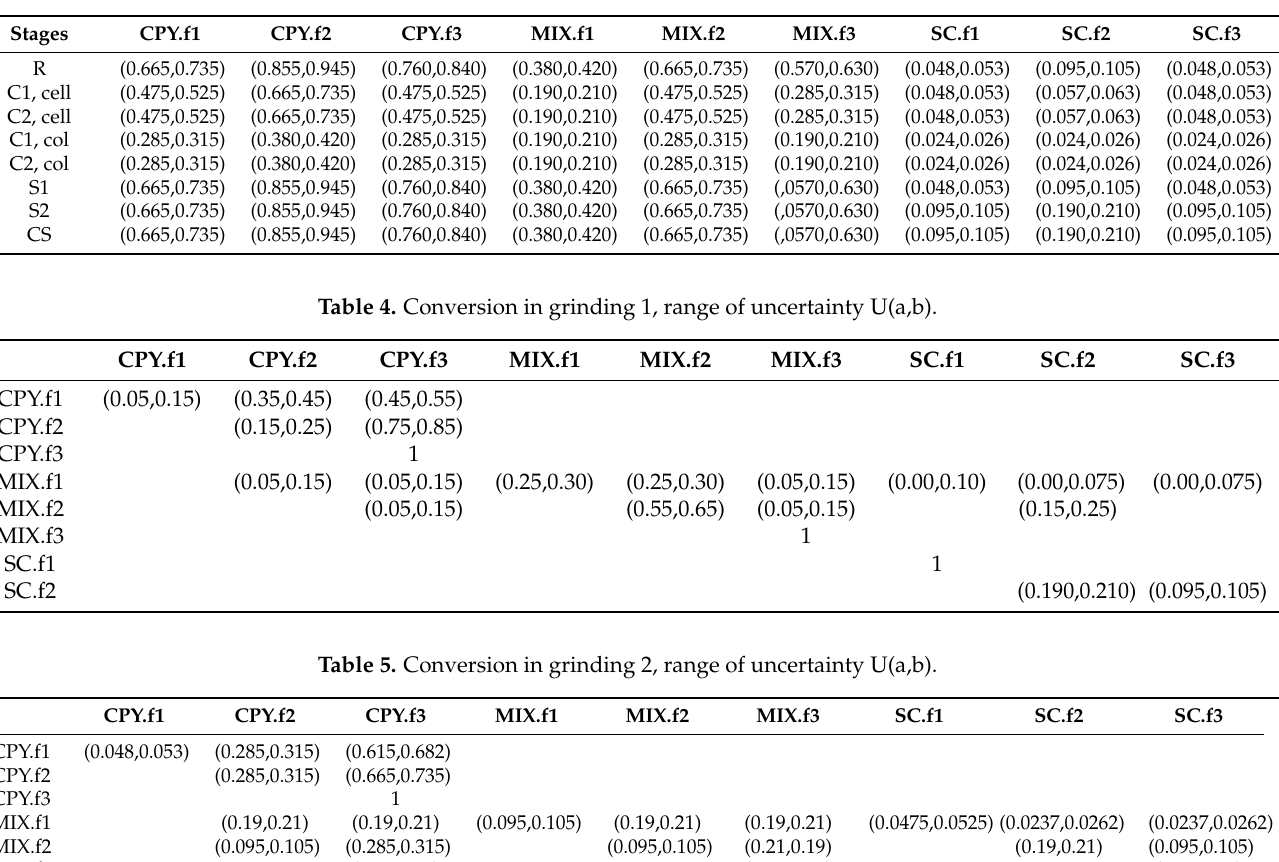
Table 3. Recovery in flotation stages, range of uncertainty U(a,b).